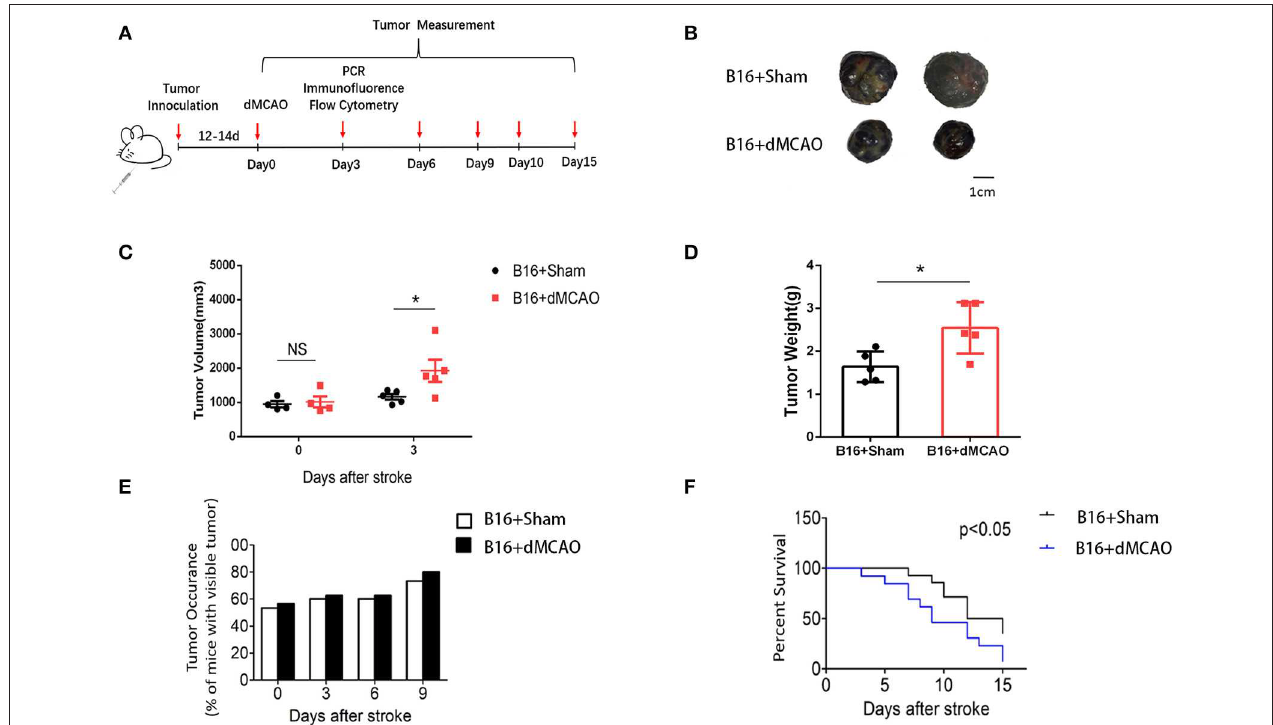
FIGURE 1 | Cerebral ischemic stroke accelerates cancer progression. (A) Schematic representation of the experimental design. (B) Representative images of tumors collected from mice of each group. (C) Tumor volume measured at indicated time points after stroke ( n = 4–6 in each group, * P ≤ 0.05). (D) Quantification of tumor weights of the above tumors collected at 3 days after stroke ( n = 6 in each group, * P ≤ 0.05). (E) Percentage of tumor occurrence in mice with visible tumor among mice inoculated with B16 cell line ( n = 6 in each group). (F) Overall survival analysis of mice in the two experimental groups up to 15 days after stroke ( n = 13 in sham group, n = 14 in stroke group, * P ≤